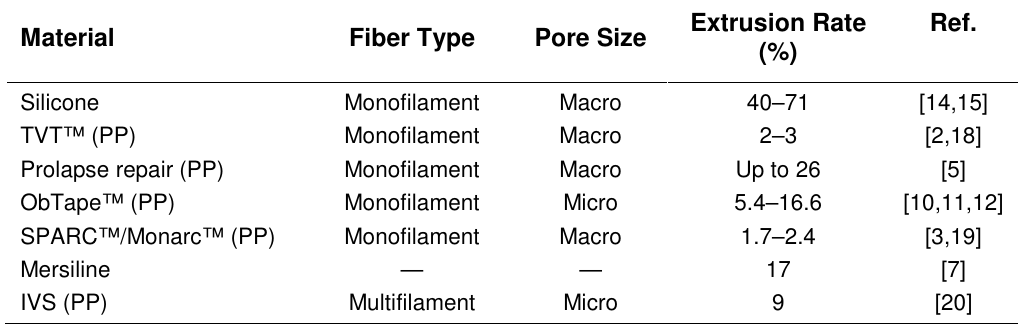
Synthetic Mesh Types, Characteristics, and Associated Vaginal Extrusion Rates*